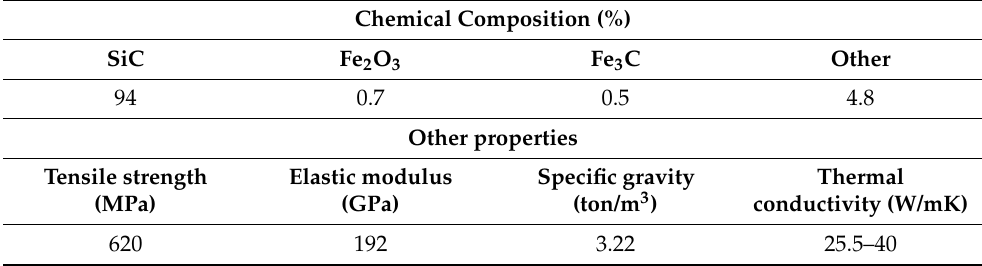
Table 3. Properties of SiC.